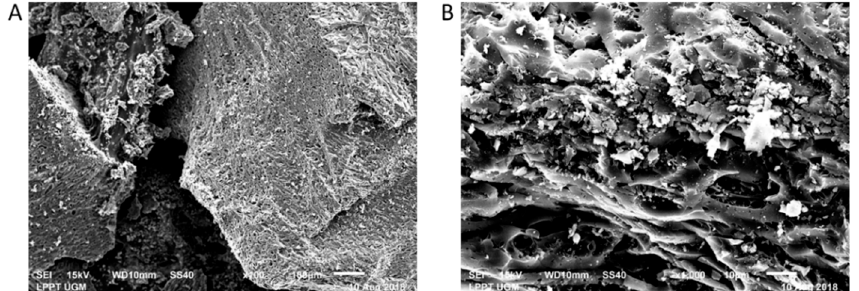
Figure 3. SEM micrograph of CSC at 100 × magnification ( A ) and 1000 × magnification ( B ).